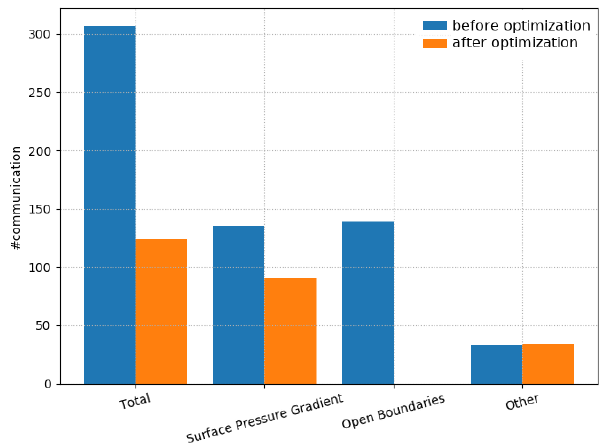
Figure 8. Comparison between the number of communications needed at each time step in NEMO before (blue) and after the opti- mizations of this section were carried out (orange) for a configura- tion with open boundaries and without